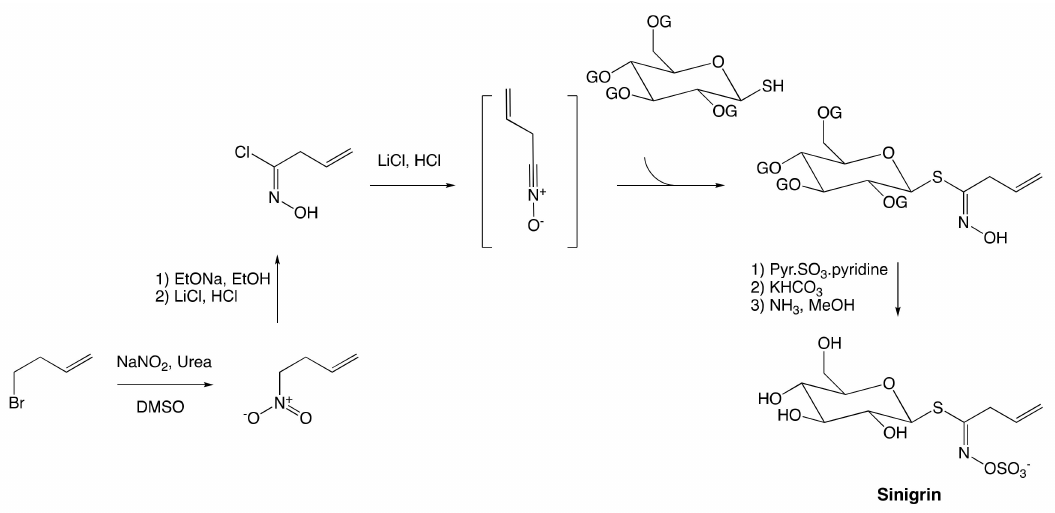
Figure 7. Synthesis of sinigrin employing nitronate pathway.